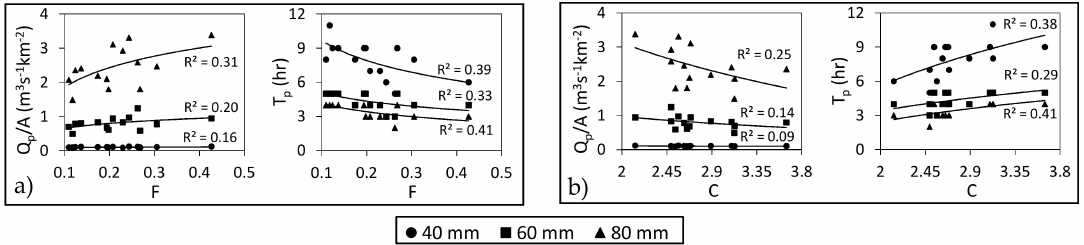
Figure 13. Relationship between the hydrological indices and some basin shape parameters: ( a ) form factor ( F ) and ( b ) compactness ( C ) with different storm